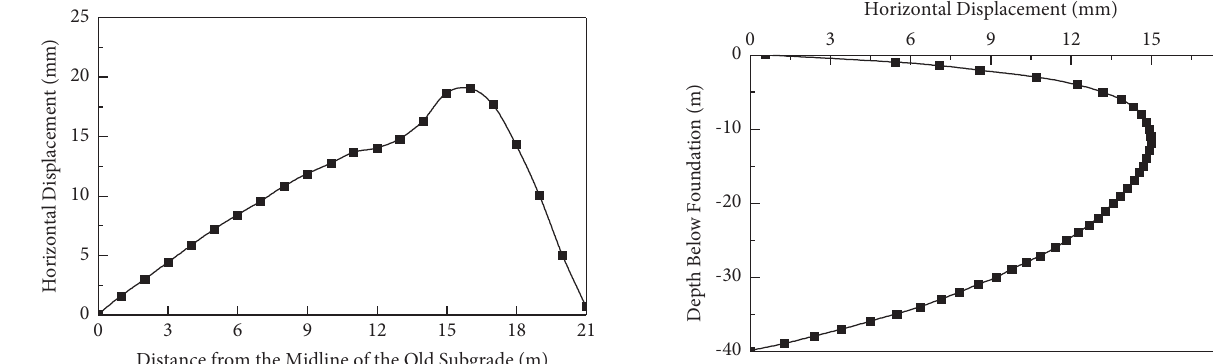
Figure 8: Horizontal displacement of subgrade top surface.